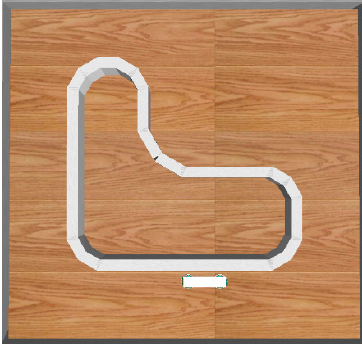
Figure 21. Training environment for cooperative carrying.